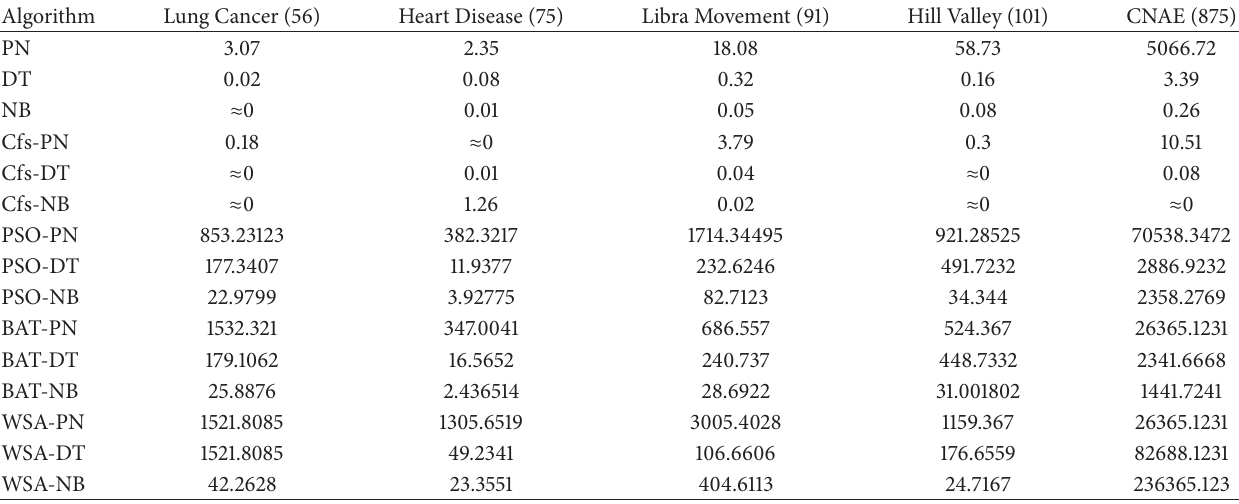
Table 6: Comparative results in time consumption (in seconds) for all the classification algorithms with Cfs feature selection and swarm search feature selection and without any feature selection.